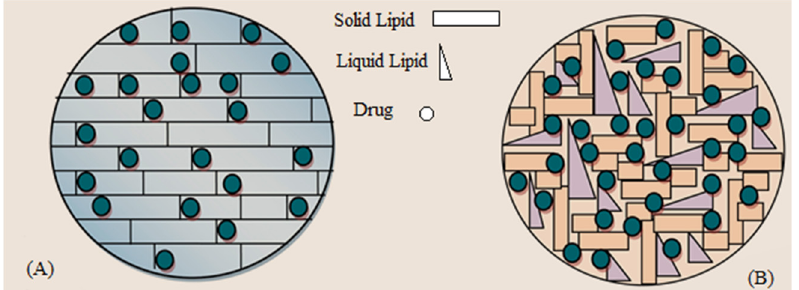
Figure 1. Schematic presentation of lipid nanocarriers; Solid lipid nanoparticles ( A ) and Nanostructured Lipid Careers ( B ).